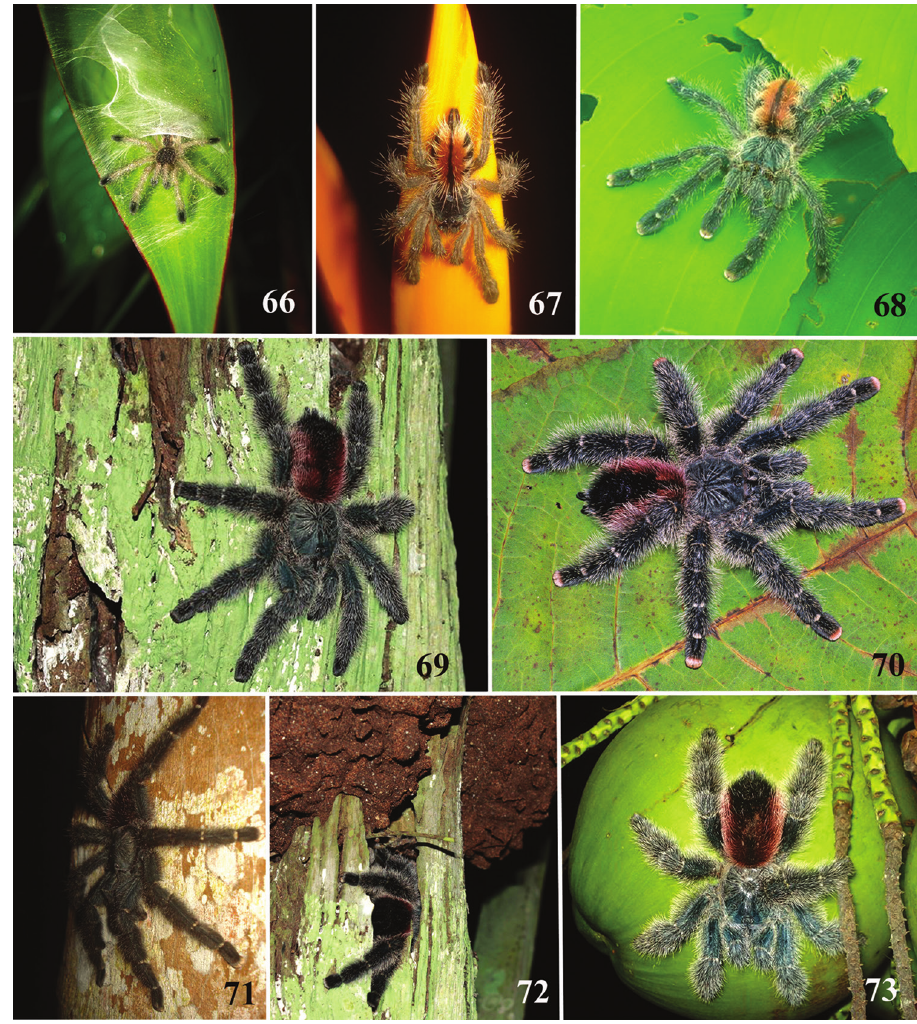
Figures 66–73. Avicularia variegata stat. n., morphotype 1, habitus 66 immature on leaf retreat 67 im- mature 68 juvenile 69 juvenile female 70 female 71 male 72 adult inside retreat on tree bark 73 female in coconut tree. Photos: 66–69, 71–73 Marlus Almeida; 70 R. C. West.